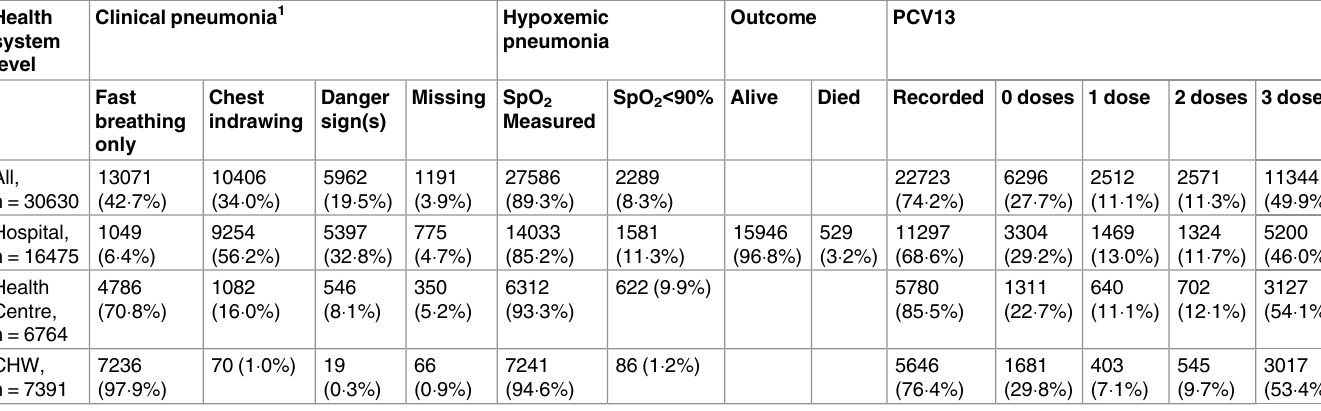
SpO 2 indicates peripheral oxygen saturation; CHW, community health worker. See S4 Appendix for breakdown by 0–5, 6–23 and 24–59 month age groups. 1